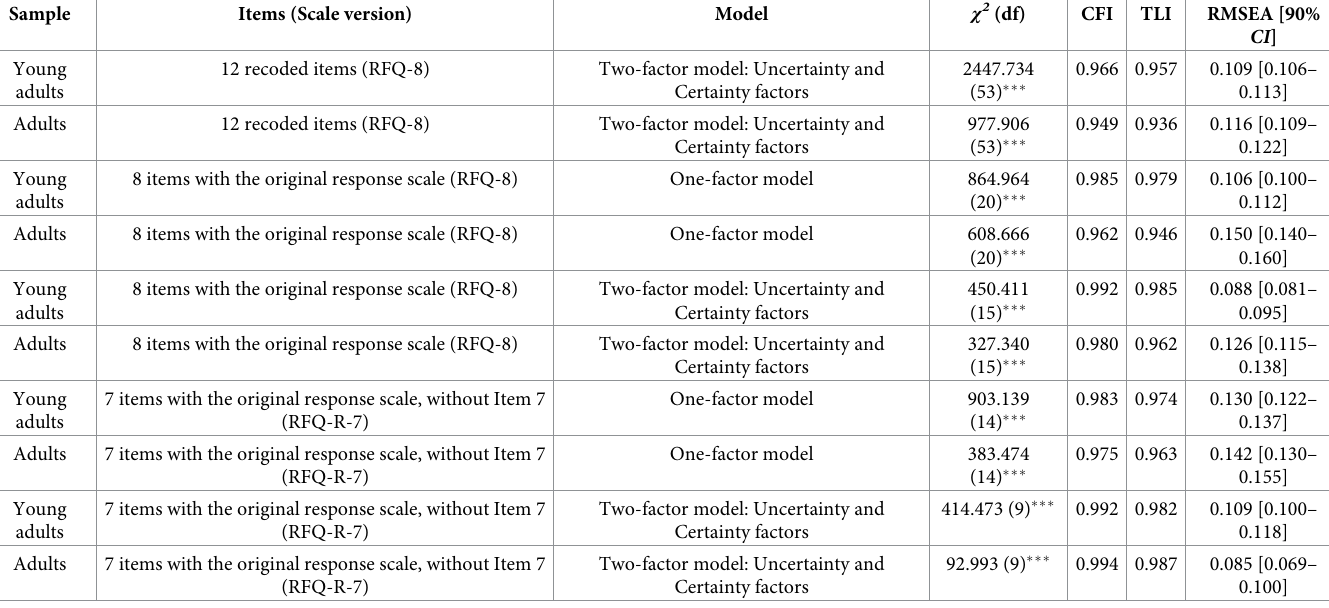
Table 1. Model fit of the measurement models of the Reflective Functioning Questionnaire.